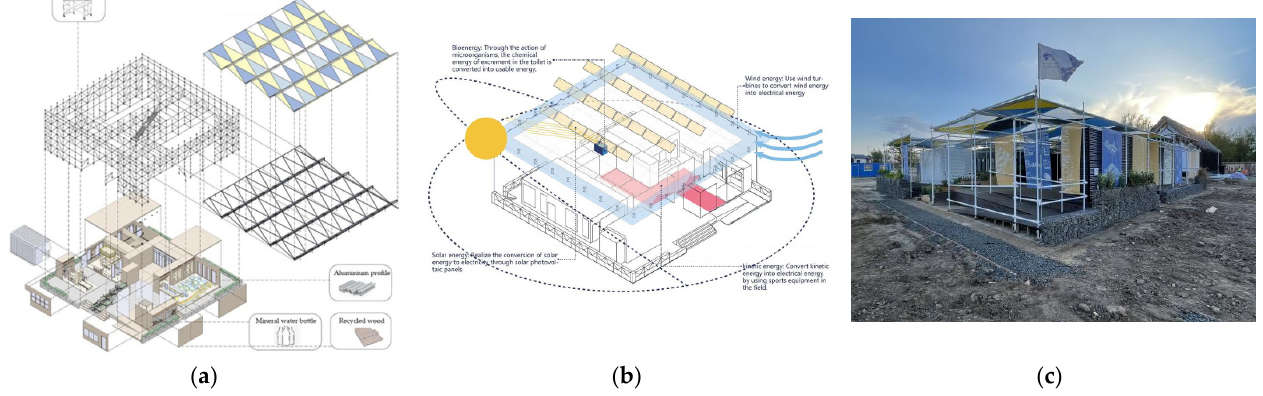
Figure 14. Main results of the BBBC. ( a ) Recyclable materials. ( b ) Energy self-sufficiency. ( c ) BBBC building.